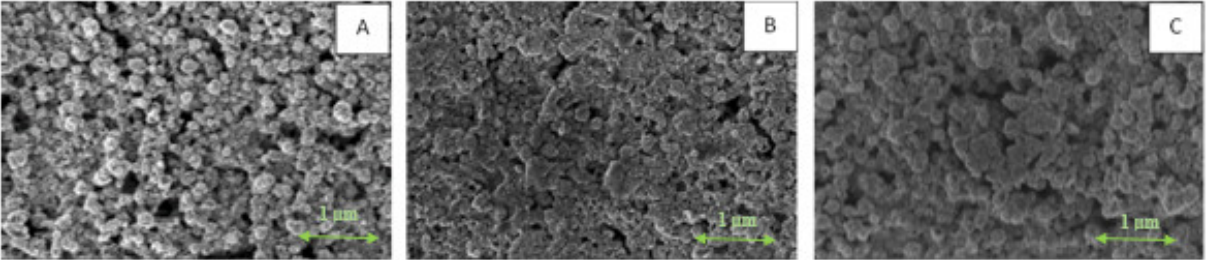
Figure 8. SEM images of Ni@Ag coatings after drying ( A ); after drying, dipping in OA (1 wt%) and drying (40 °C) ( B ); after drying, dipping in OA (1%) followed by drying and sintering (100 °C, 30 min) ( C ).